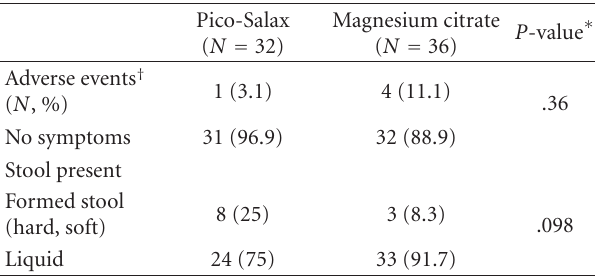
Table 3: Comparison of tolerability and stool type between Pico- Salax and magnesium